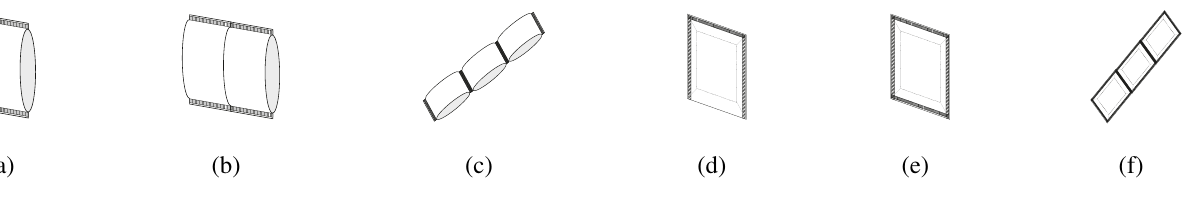
Figure 2. Common shapes of flat pouches used for bag chains. ( a , b ) tubular pouches produced with or without side gussets; ( c ) a chain of tabular bags; ( d ) 3-side sealed bag; ( e ) 4-side sealed bag; ( f ) sealed seam bags as double or chain.